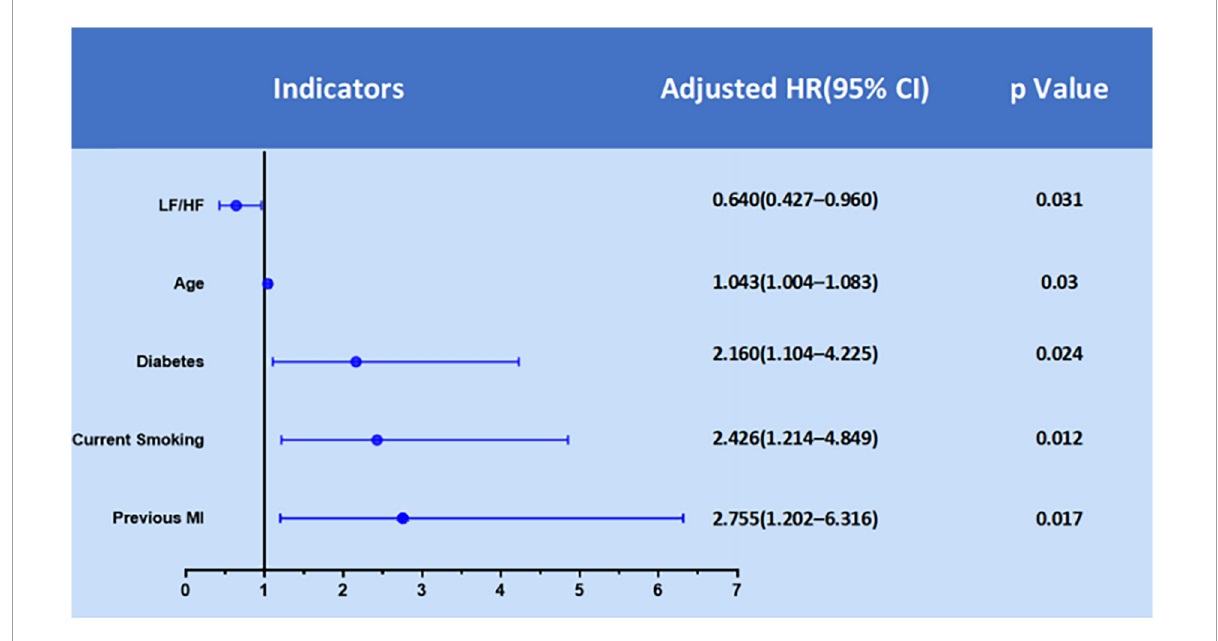
FIGURE2 Significant predictors of MACEs in the development cohort from multivariate Cox regression analysis.